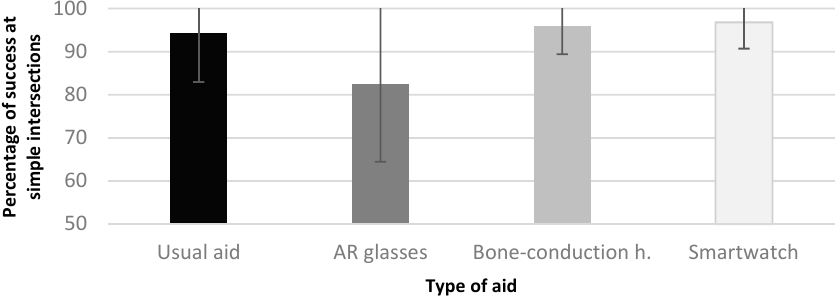
Figure 8. Percentage of success at simple intersections. Vertical bars represent standard deviations.